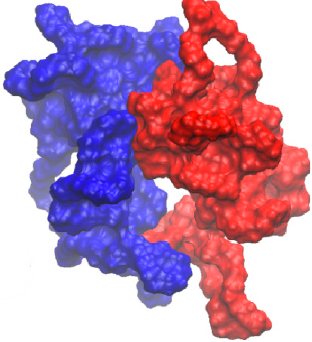
Fig ure 7. 3D interaction conformations of F68 (Blue) and PEG6000 (Red).